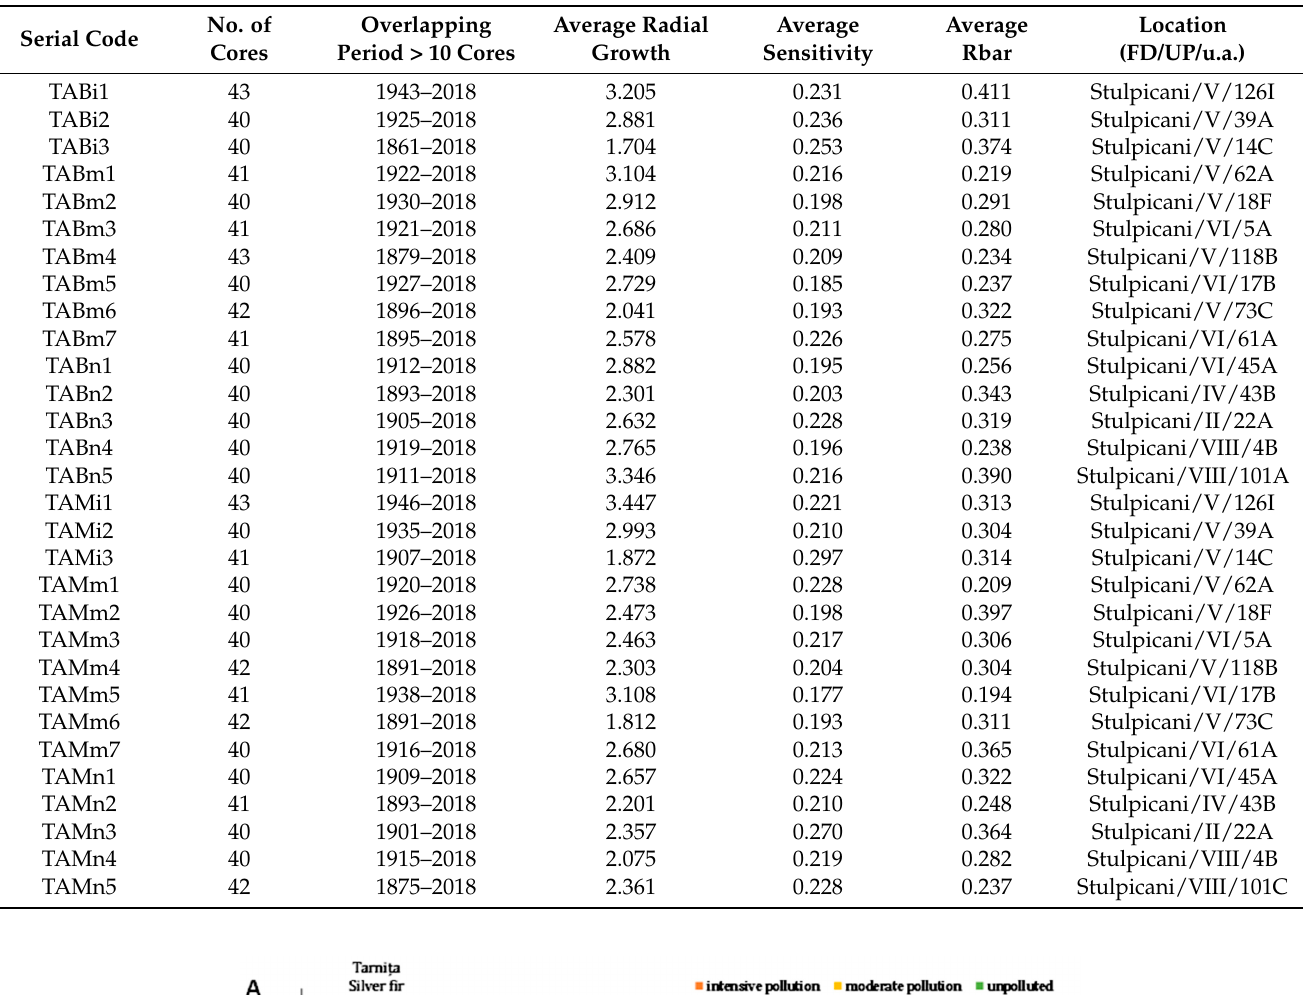
Table 2. Statistical parameters of the average radial growth series for silver fir and Norway spruce in the Tarnit